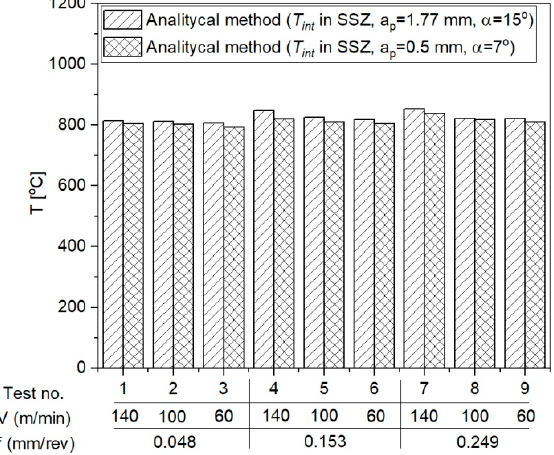
Figure 13. The mean temperatures in the SSZ obtained with the use of analytical method for two different cutting depths, a p = 1.77 mm and a p = 0.5 mm.